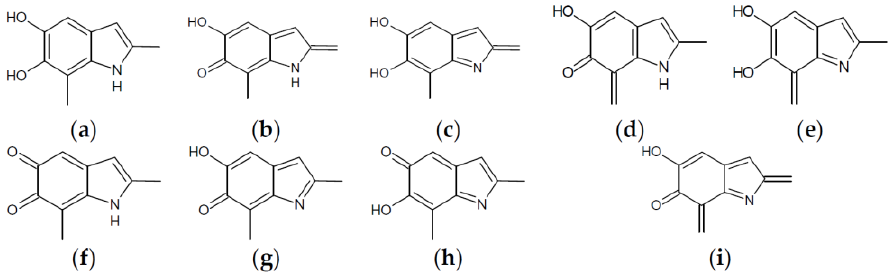
Figure 4. Building blocks for generation of staring structures of closed-shell tautomers of Kaxiras’s porphyrin. ( a ) Fully reduced units. ( b – e ) One-electron oxidized units. ( f – i ) Two-electron oxidized units.